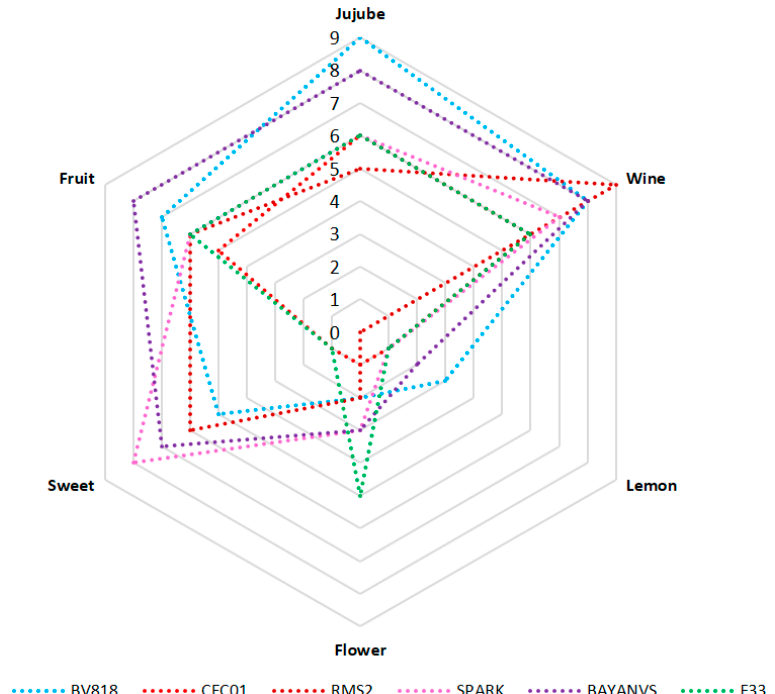
Figure 3. Canonical correlation analysis (CCA) of similarity of the jujube wine produced by the six winemaking yeasts. The plot was defined by canonical variates 1 and 2.